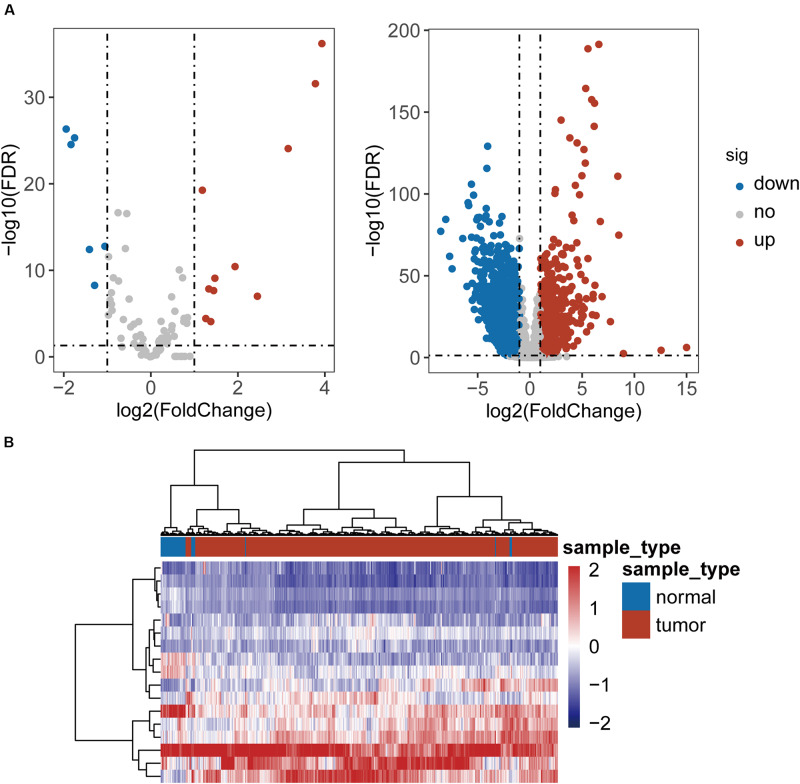
Differential expressed analysis of TLR-related genes between 41 paired CRC and control samples. (A) Volcano plot of the distribution of differentially expressed TLR-related genes. (B) Hierarchical clustering heatmap and dendrogram of 468 TCGA CRC samples based on differentially expressed TLR-related genes.